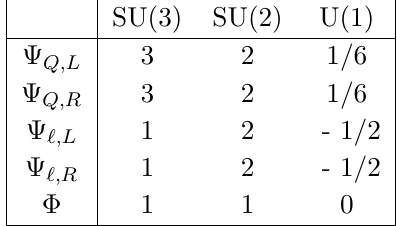
Table 1 . Multiplet structure of the additional states under SU(3) (cid:2) SU(2) (cid:2)